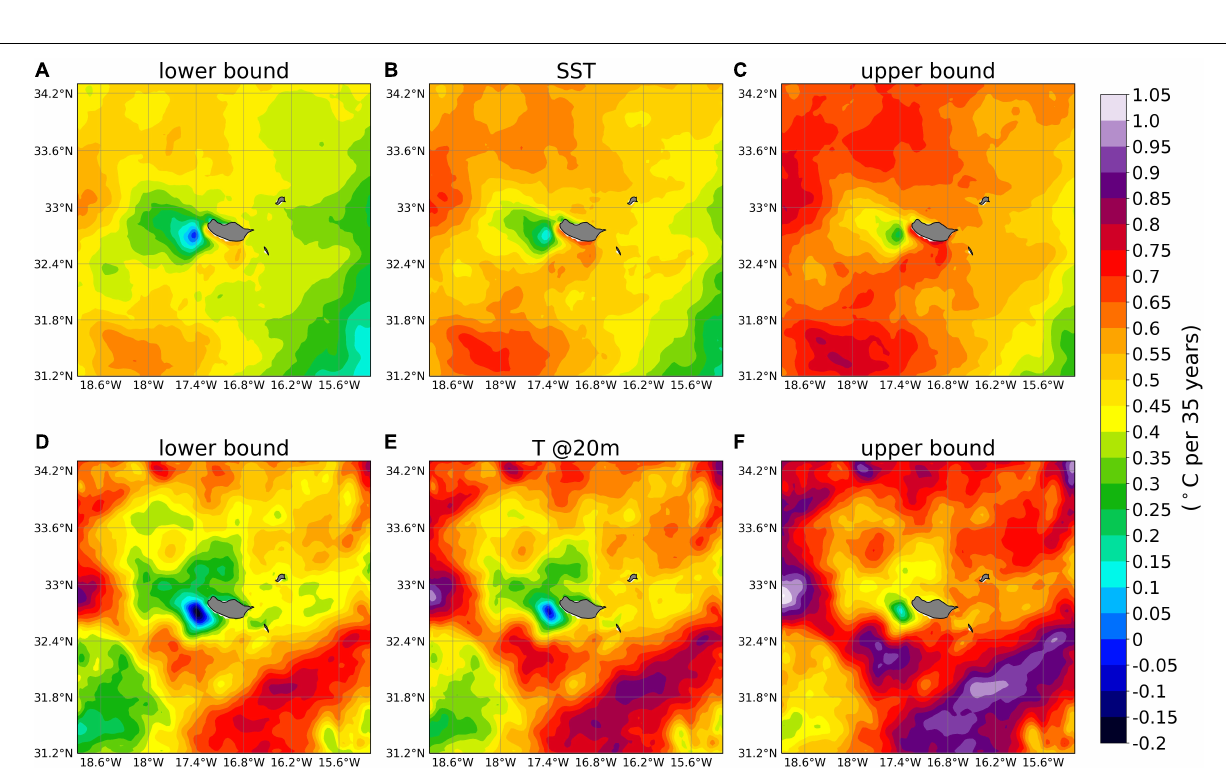
Frontiers in Marine Science |